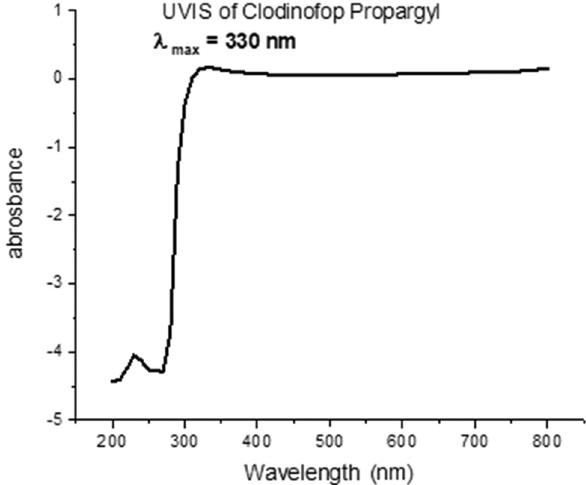
Figure 5: UV - Vis absorption spectrum of chitosan - based NPs of clodinofop propargyl.